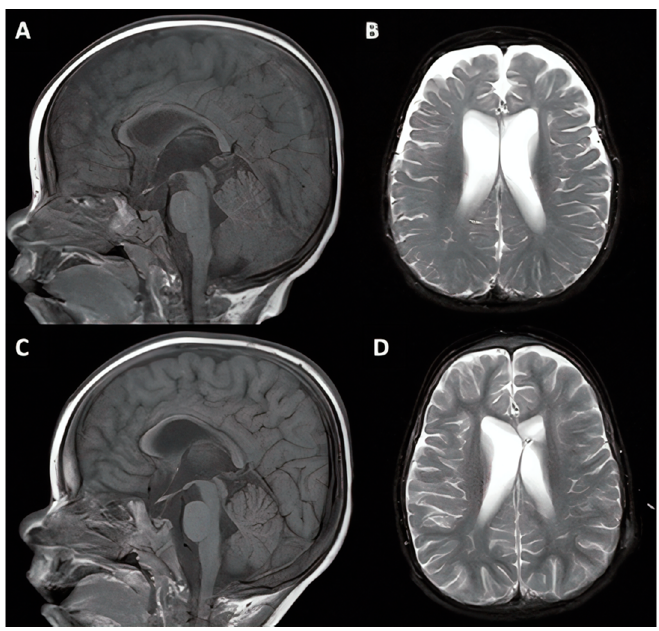
Figure 3. 17-month-old male patient with cerebral palsy (case #2). Pre-operative ( A , B ) and 1 year post-operative ( C , D ) T1-weighted midsagittal and T2-weighted axial magnetic resonance imaging